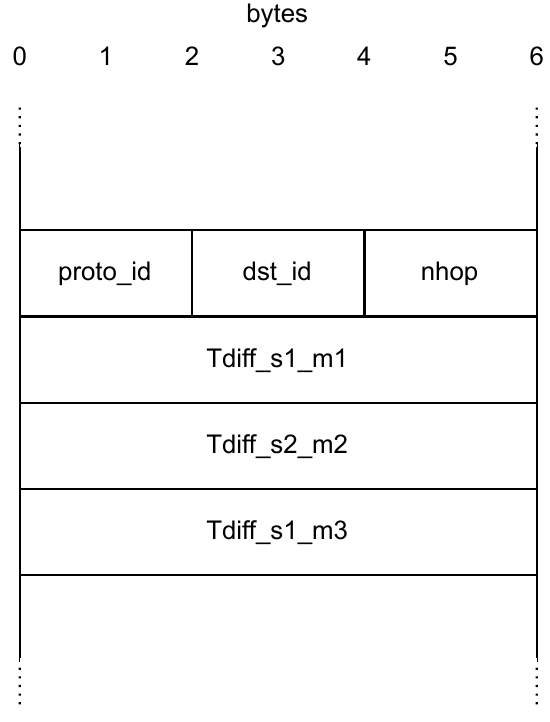
Figure 2. Custom header for P4DM